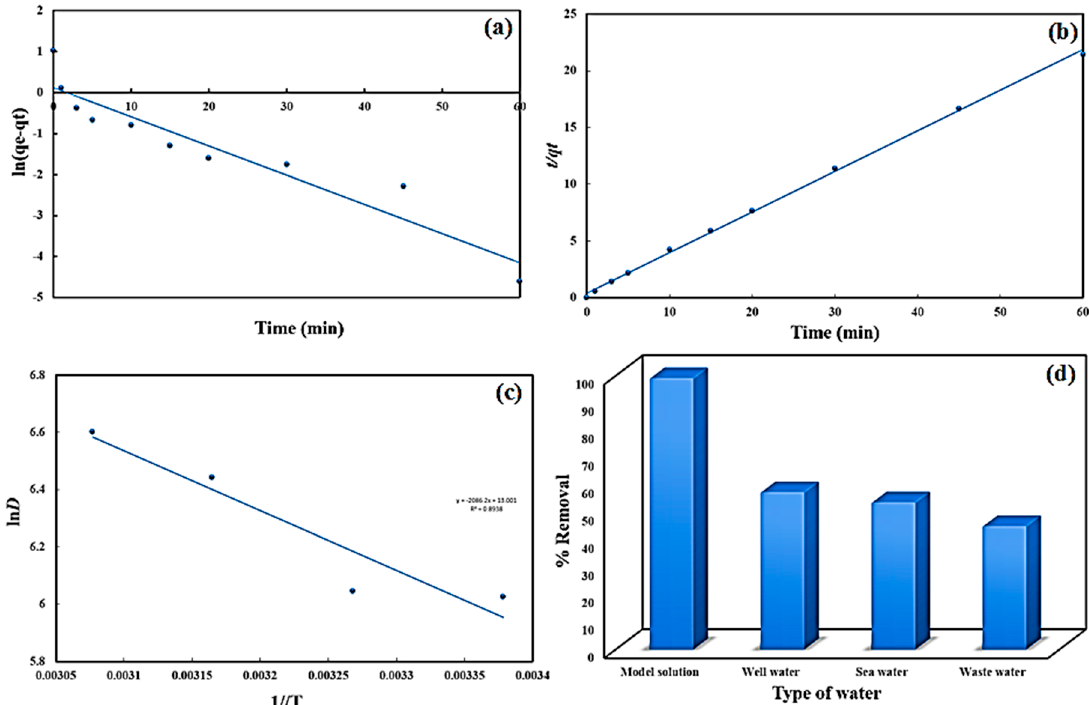
Figure 10. Kinetic models for the adsorption removal of AR1 by PMG50 composite. ( a ) PFO model and ( b ) PSO model. ( c ) the plot of ln D vs. 1/ T for calculating thermodynamic parameters. ( d ) % removal of AR1 dye from different water sources.